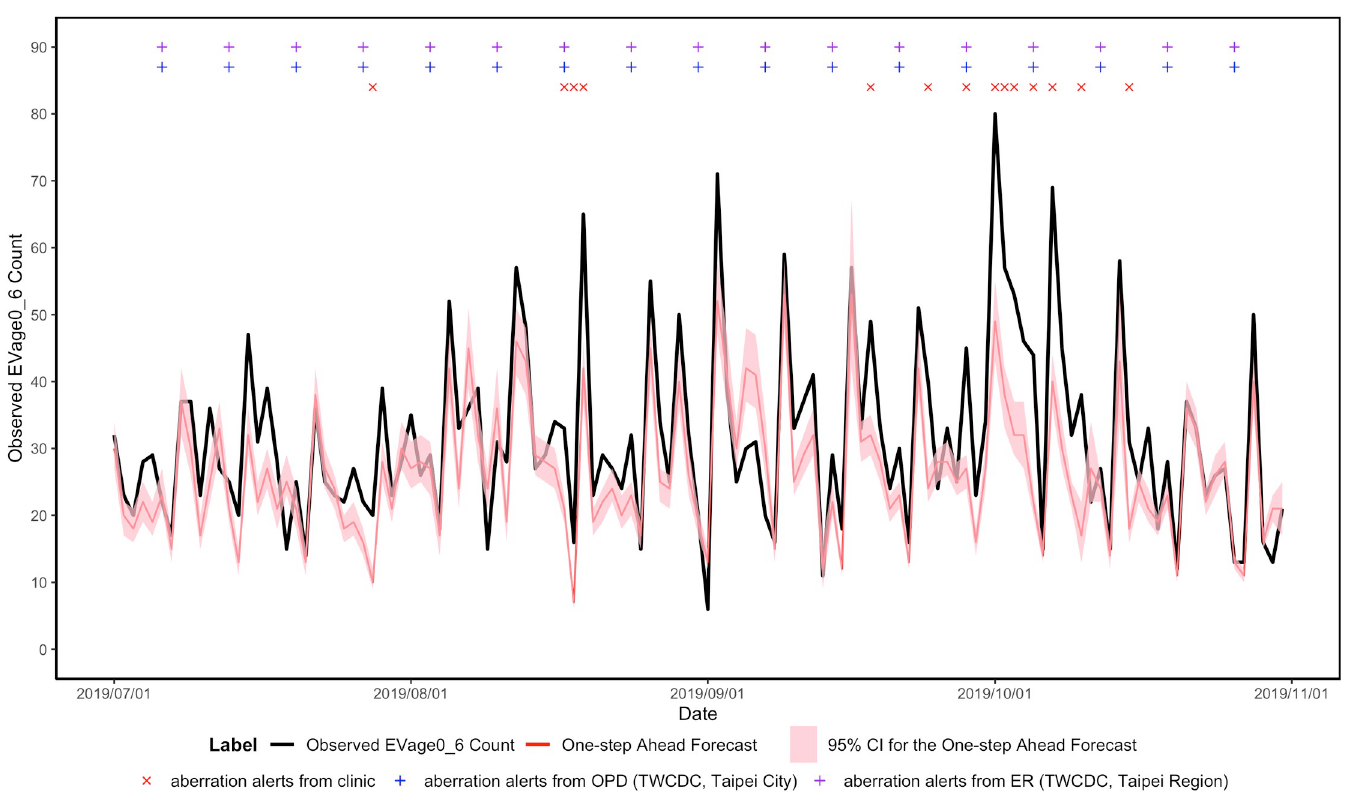
Fig 5. One-step-ahead forecasts for forecast period for EV syndromes in a rolling